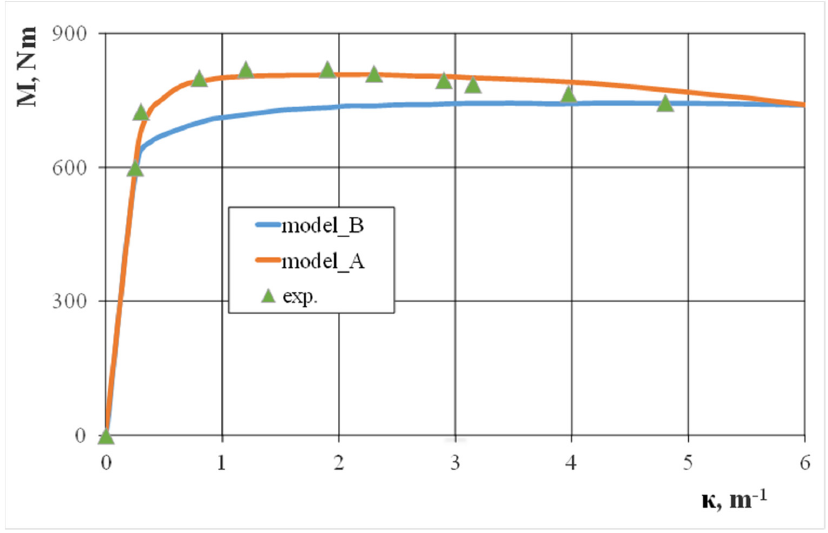
Figure 11. The e ff ect of bending curvature on the bending moment of the 25 × 25 × 2 square steel